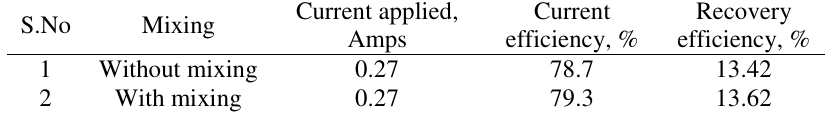
Table 4. Effect of Mixing on Current and recovery efficiency with unmodified electrode S.No